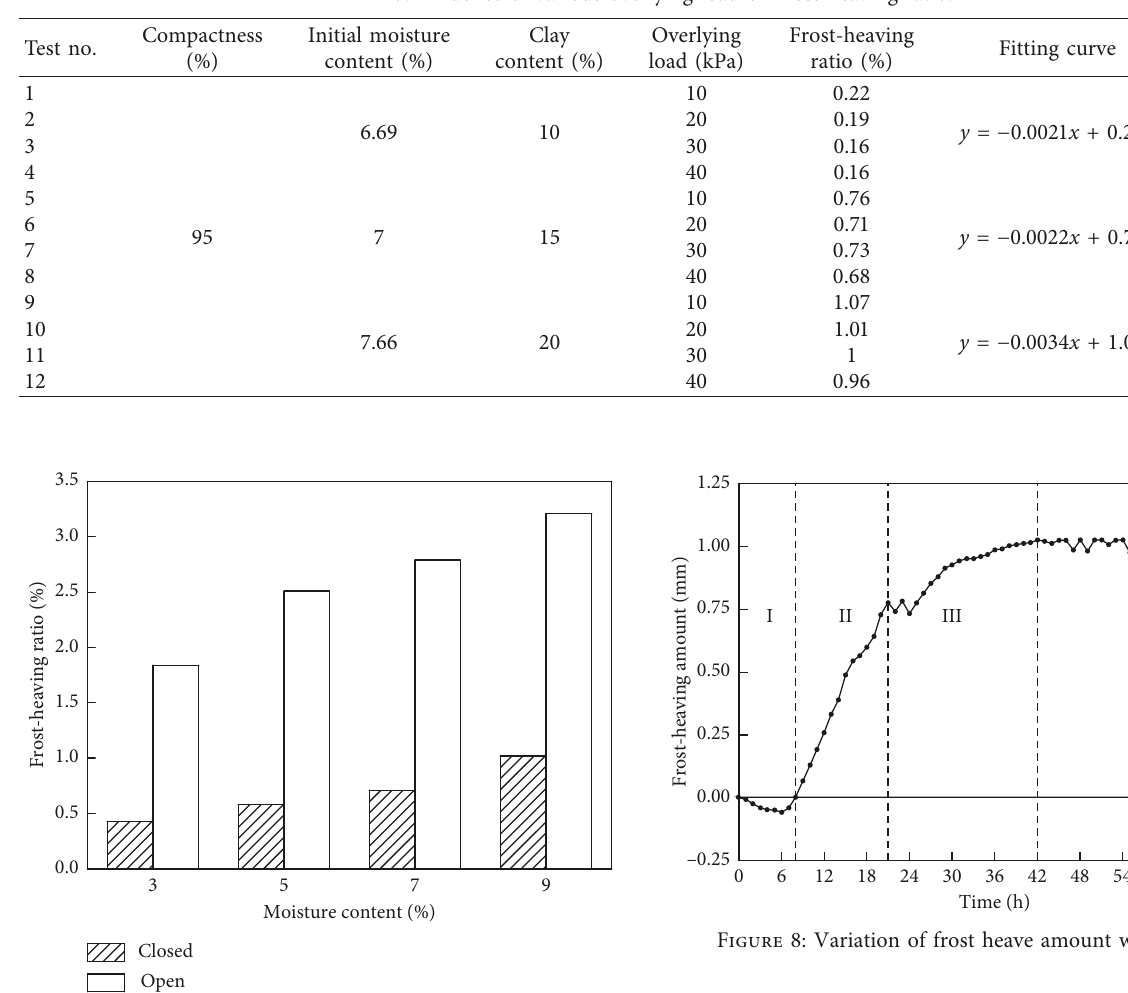
Table 5: Influence of various overlying load on frost-heaving ratio.